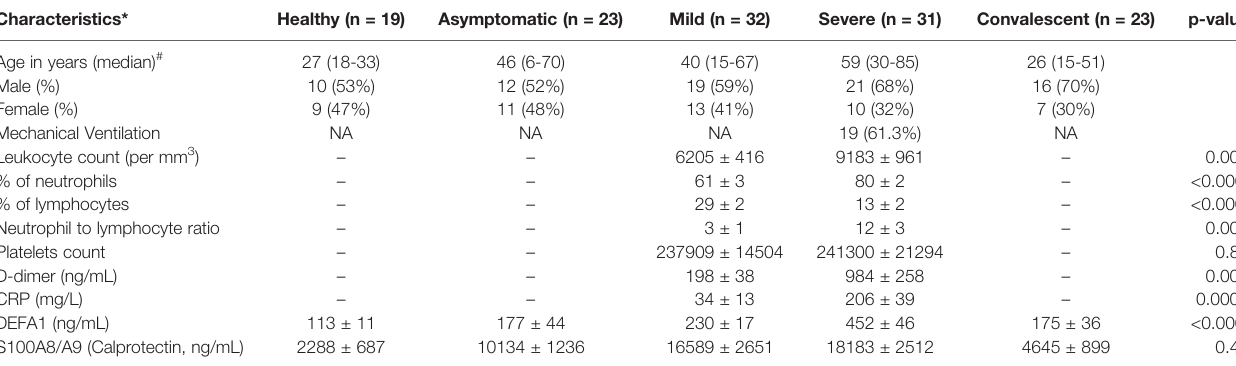
TABLE 1 | Details of the COVID-19 patients examined at